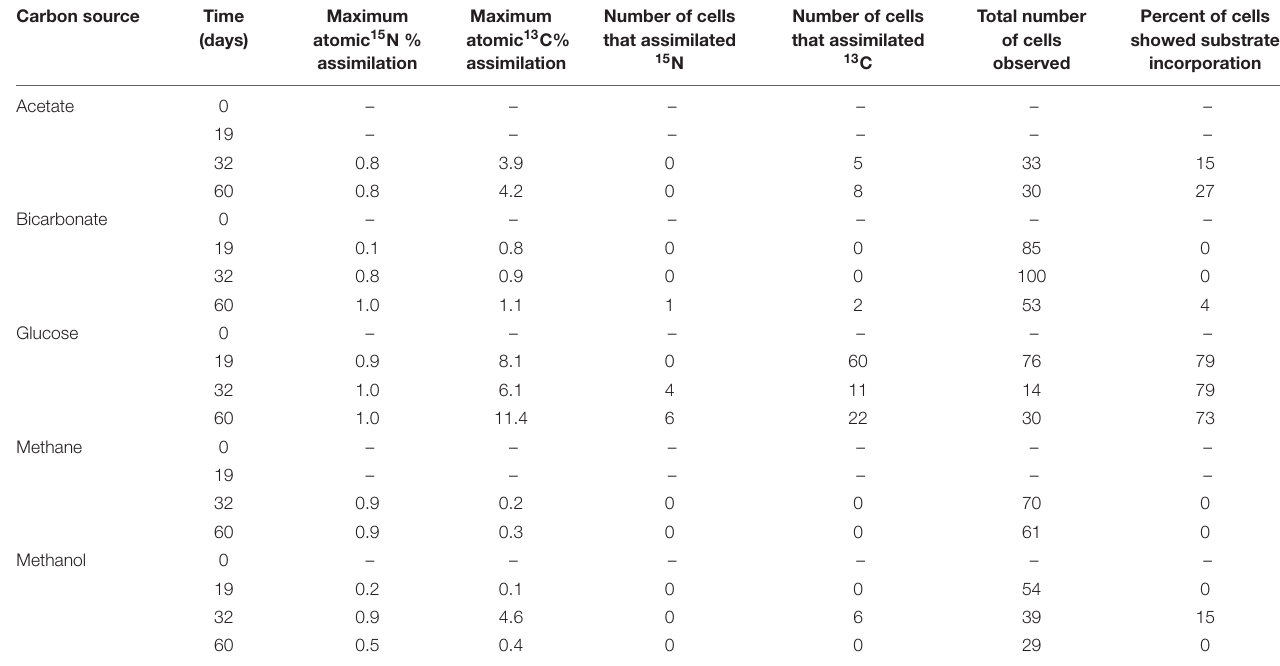
TABLE 1 | Summary of 13 C assimilation in individual cells. Carbon